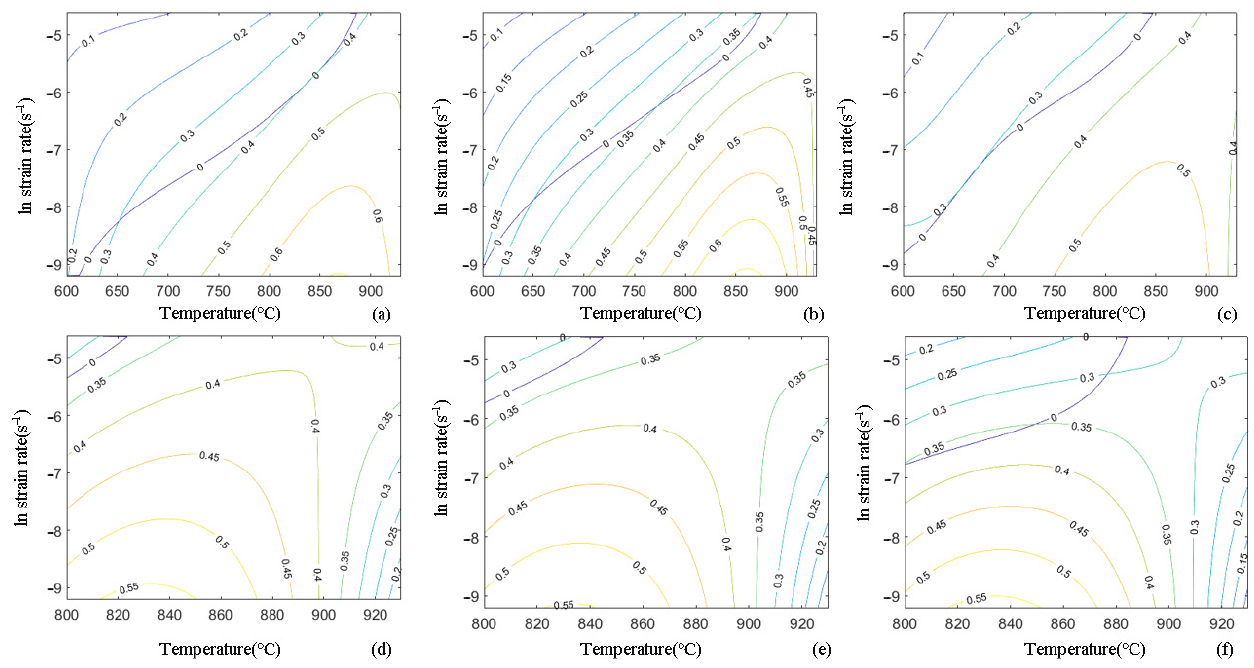
Figure 6. The processing map for Ti-6Al-4V alloy during the air cooling after superplastic forming: ( a ) 0.1; ( b ) 0.2; ( c ) 0.3; ( d ) 0.5; ( e ) 0.6; and ( f ) 0.7.